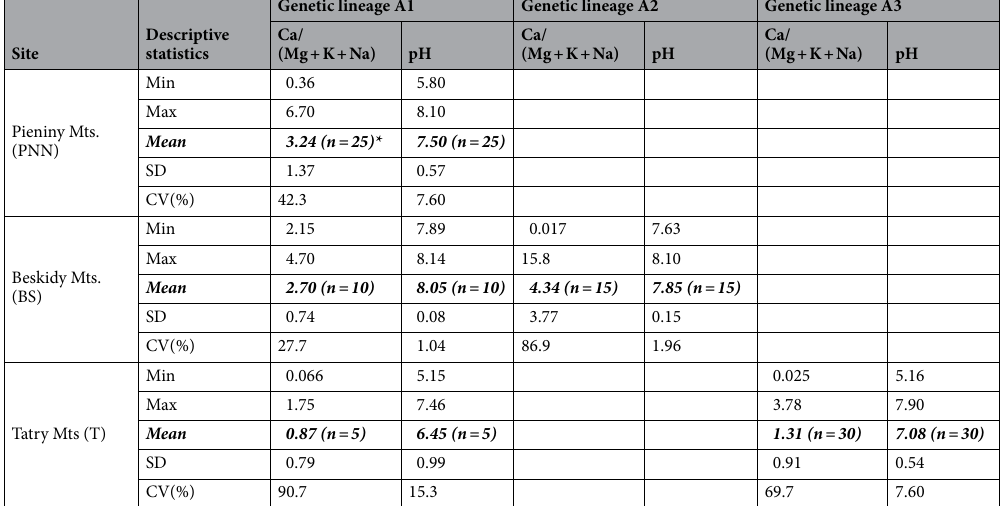
Table 4. Global site specific index of active forms of alkaline elements (Ca, Mg, K, Na) and pH (alkalinity, acidity) in the growth media of A. pinguis cryptic species A genetic lineage A1, A2, A3 at Pieniny, Beskidy and Tatry